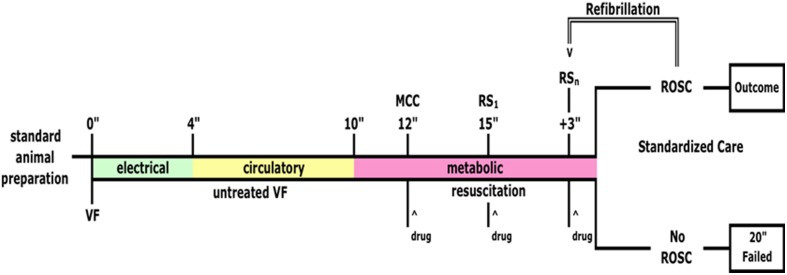
Global ischemia protocol. Ventricular fibrillation (VF) was induced as previously described (Mader et al., 2010) with a transthoracic current (100 mA at 60 Hz) and was untreated for 12 min. VF lasted for 4 min before complete electrical failure was reached (green bar) at which point circulation stopped completely (yellow bar) and finally metabolic failure is reached at ~10 min. (pink bar). Resuscitation efforts began 12 min after induction of VF, initially with manual chest compressions (MCC) and infusion of epinephrine (drug, 0.1 mg/kg). At minute 15 we attempted to restart circulation electrically (RS1) and at 18 min. If spontaneous circulation returned (ROSC) it was maintained for 2 h and then the animals were sacrificed and cardiac muscle samples taken from the left ventricle (Ischemia + 2 h reperfusion). If ROSC was not restored then after 20 min cardiac muscle samples were taken from the LV (Ischemia + failed resuscitation). Control animals were prepared identically but did not receive the ischemia protocol (Control). ^ Indicates when a drug was administered.